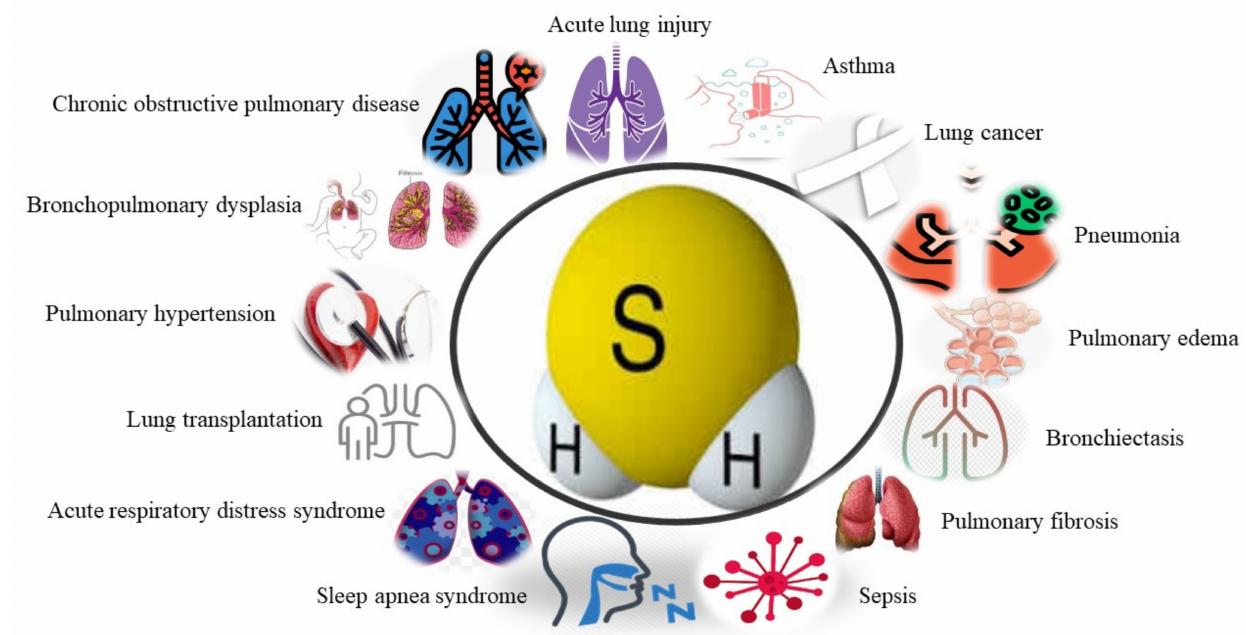
Figure 3. The roles of H 2 S in human respiratory diseases, including COPD, ALI, asthma, lung cancer, pneumonia, pulmonary edema, bronchiectasis, pulmonary fibrosis, sepsis, SAS, ARDS, lung transplantation, pulmonary hypertension and bronchopulmonary dysplasia. COPD: chronic obstructive pulmonary disease; ALI: acute lung injury; ARDS: acute respiratory distress syndrome; SAS: sleep apnea syndrome; BPD: bronchopulmonary